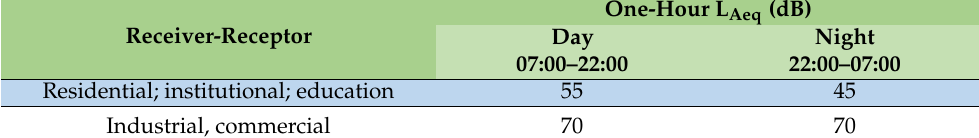
Table 3. Recommended noise levels (World Bank) (The stated values refer to noise in the external environment, outside the building, on the facade of the building (Guidelines for Community Noise, World Health Organization (WHO), 1999)).